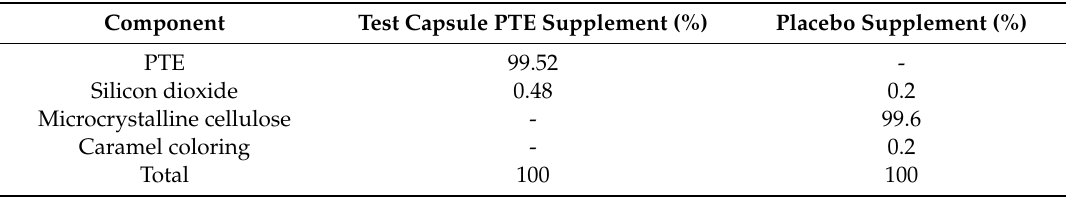
Table 1. Composition of the test product as determined by